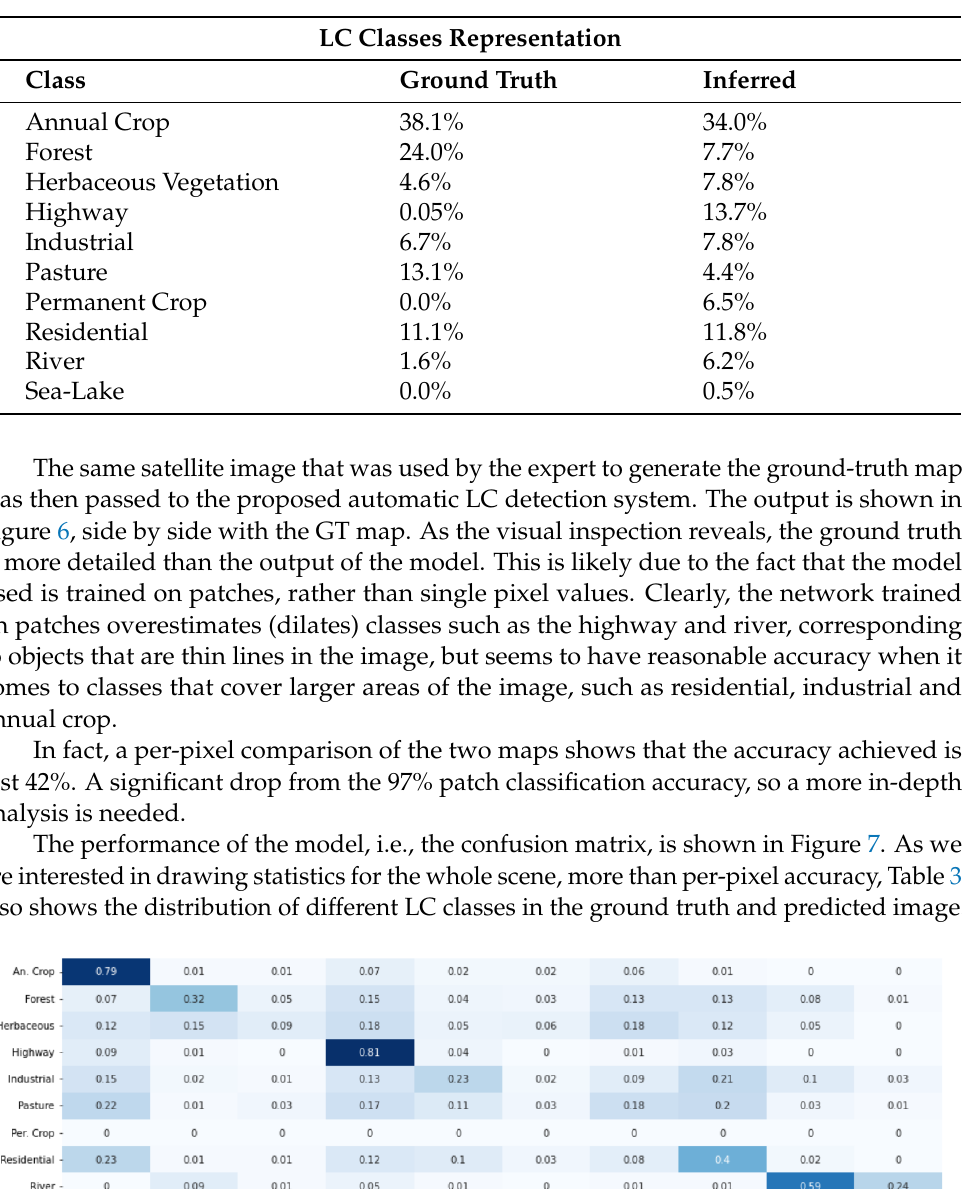
Table 3. Distribution of land cover classes for ground truth vs. inferred.